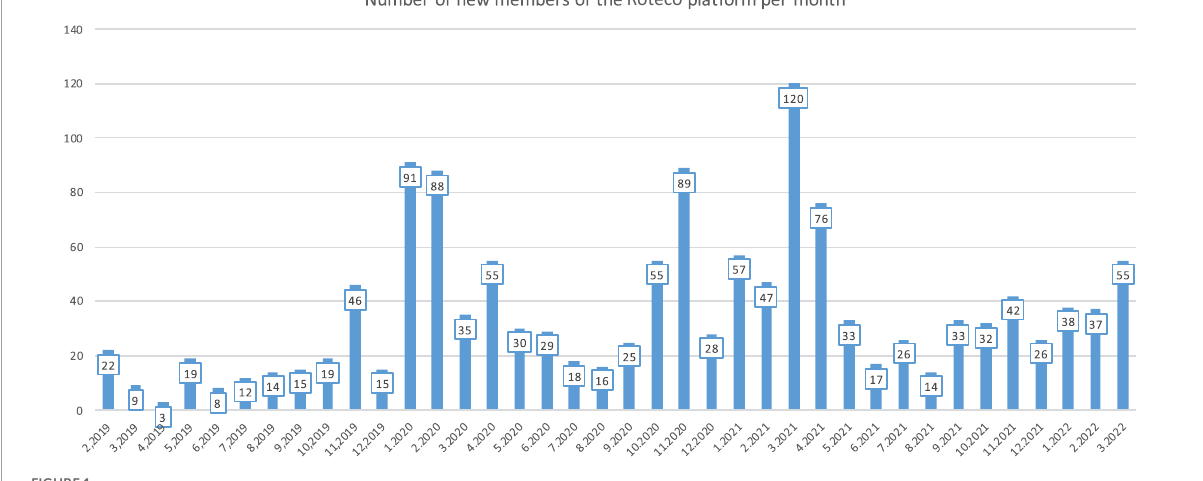
FIGURE1 Number of new members registered on the Roteco platform per